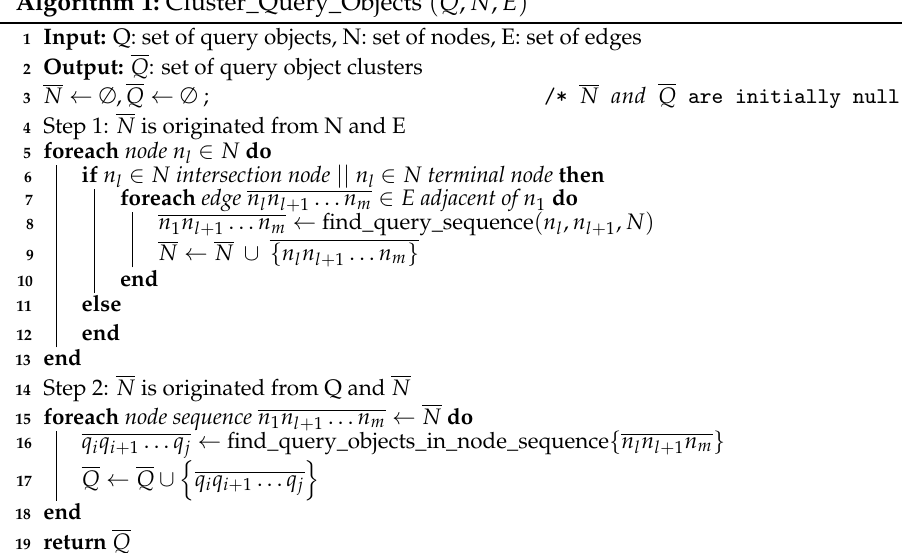
Figure 3b represents the clustering process of query objects in the same node